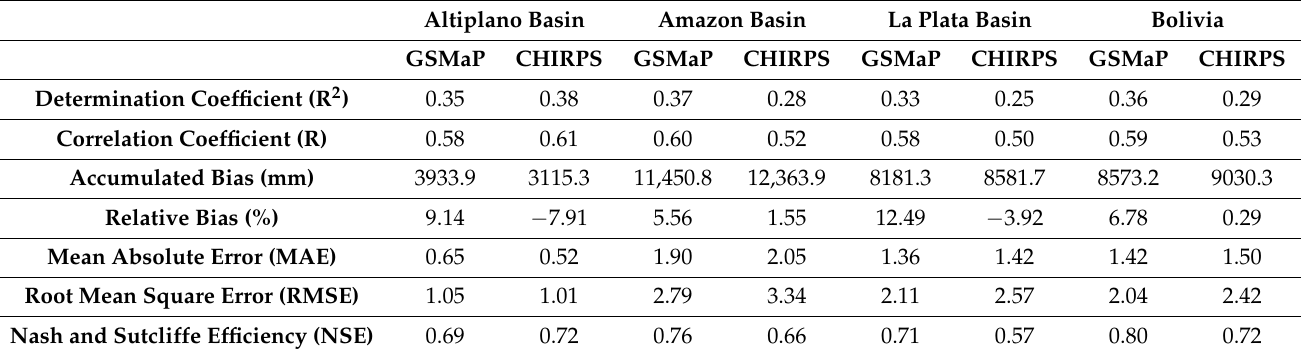
Table 1. Statistics indicators for SBP products in relation to rain gauges.